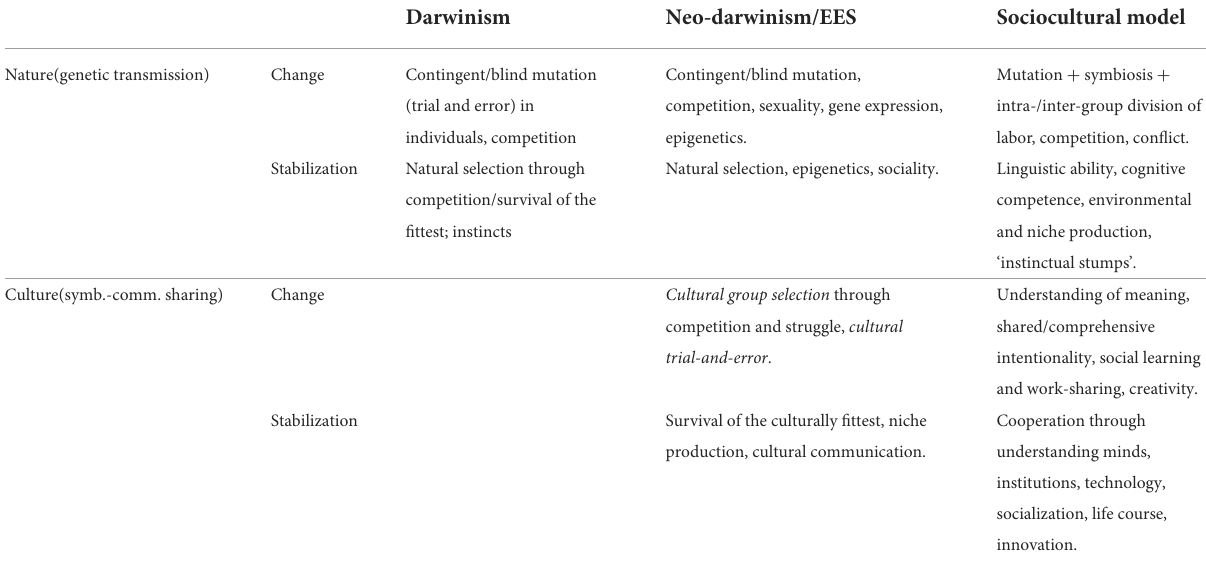
TABLE 1 Three conceptual stages of